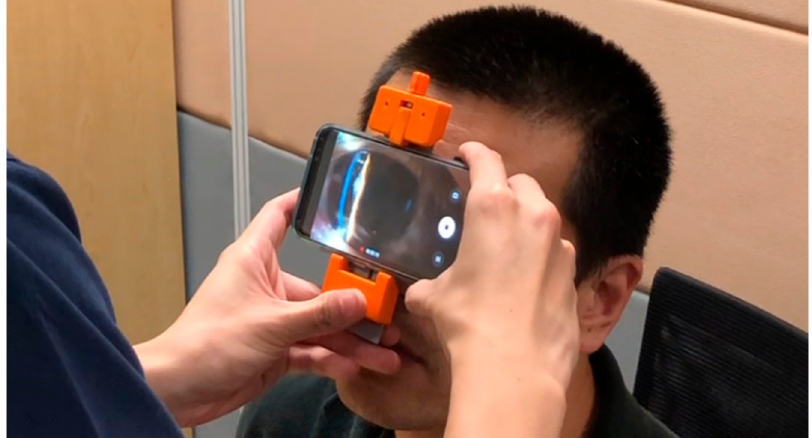
Figure 1. Sample of a MIDAS device in use.